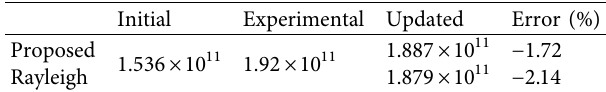
Figure 9: FE model (a) and experimental set up (b) for the cantilever beam. Table 9: Values of the elastic modulus (N/m 2 ) before and after updating.